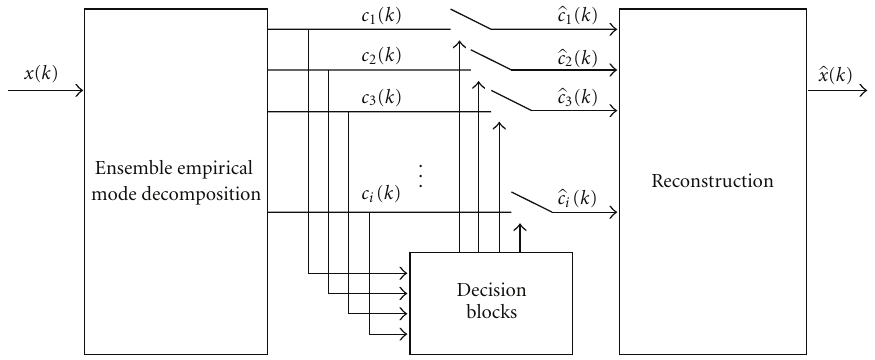
Figure 1: Conceptual model of noise reduction method using